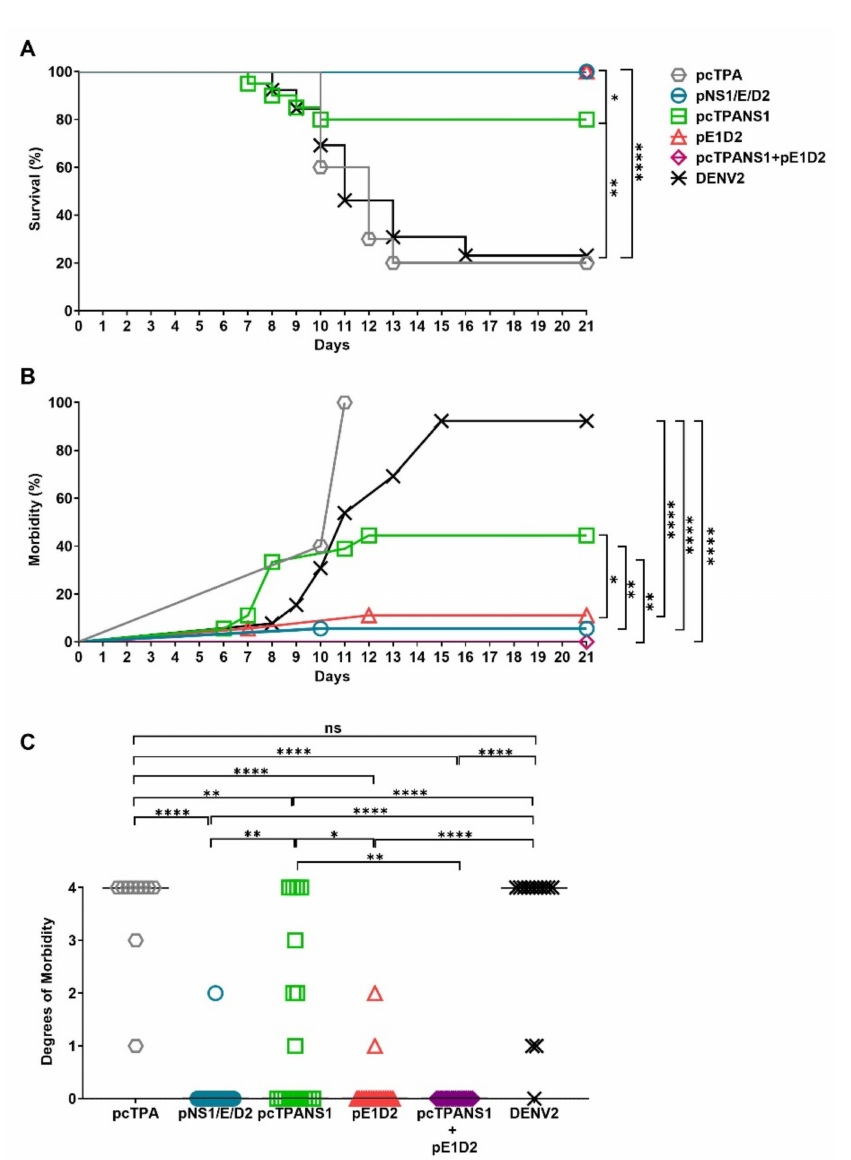
Figure 7. Protection generated in BALB/c mice immunized with the different DNA vaccines after a lethal challenge with DENV2. Animals were i.m. immunized with the different DNA vaccines and monitored for 21 days after DENV2 inoculation by the i.c. route, for assessment of survival ( A ) and morbidity ( B ) rates, and the different morbidity degrees ( C ). A semi-quantitative analysis of the clinical signs of infection was made using a morbidity degree scale from 0 to 4: 0 = absence of clinical signs; 1 = paralysis in one hind leg or alteration of the spinal column; 2 = severe paralysis in one leg and alterations of the spinal column or severe paralysis on both hind legs; 3 = severe paralysis in the hind legs and alterations of the spinal column; and 4 = death. Lines represent the median of the observed degrees ( C ). Asterisks indicate significant differences between experimental groups using Log-Rank (Mantel–Cox) test in ( A , B ) or the non-parametric two-tailed Mann–Whitney statistical test in ( C ) (* p < 0.05; ** p < 0.01; and **** p < 0.0001), ns: non-significant. Data are representative of